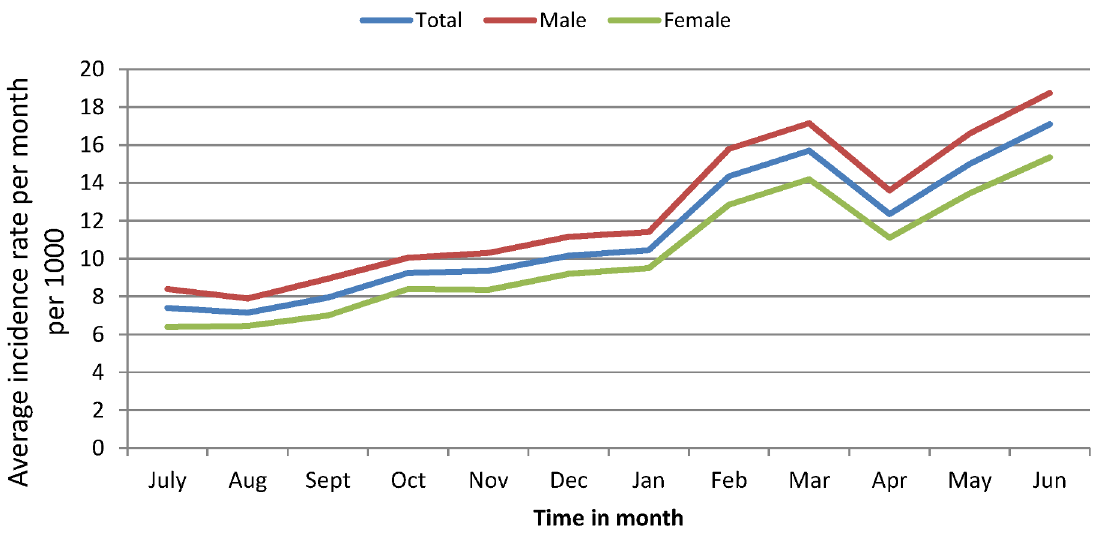
Fig 3. The averageincidence rate per 1000 of each month across one year among males and females in northwest Ethiopia, from July 2013 to June